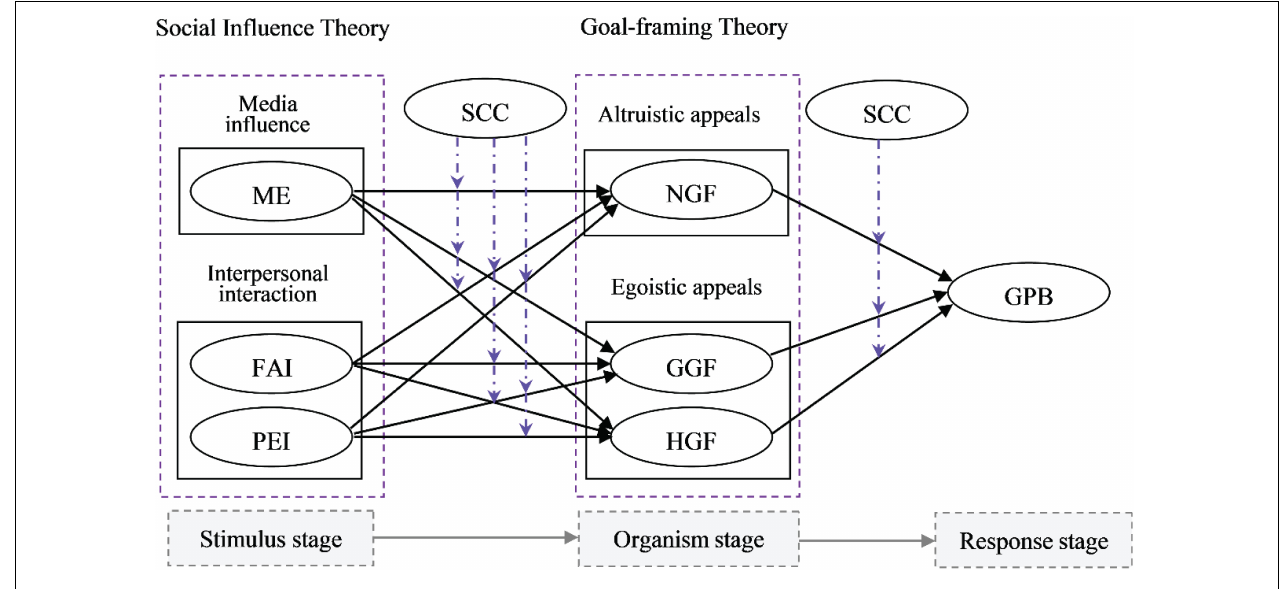
FIGURE 1 | Theoretical